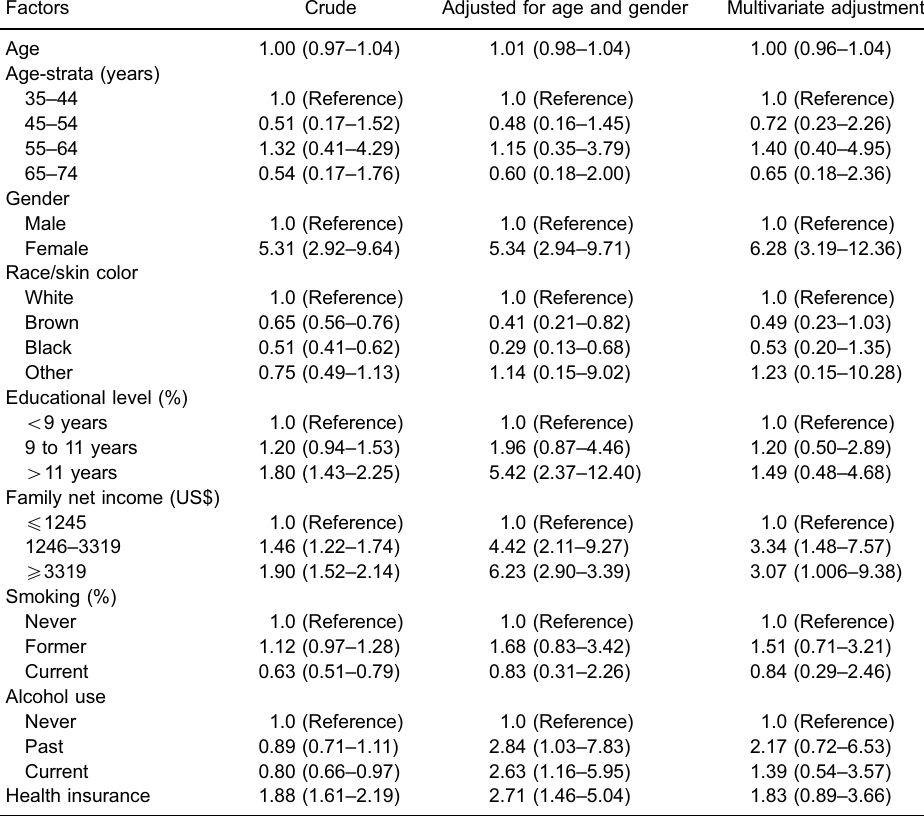
Table 4. Logistic regression model crude, adjusted by age, and multivariate adjusted by factors associated to use of levothyroxine in the ELSA-Brasil